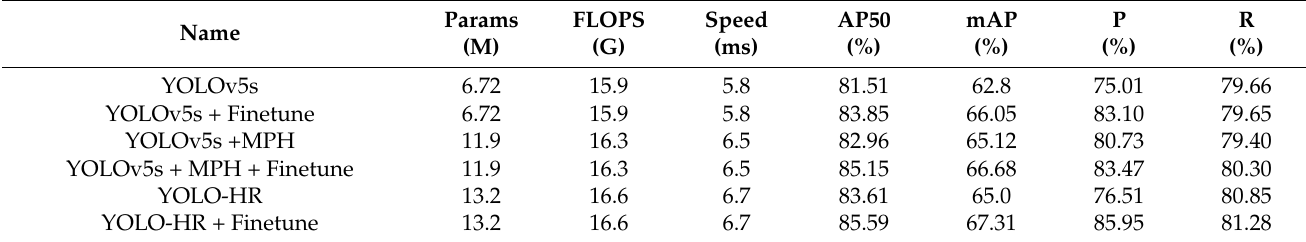
Table 4. Performance improvement of each part design on the